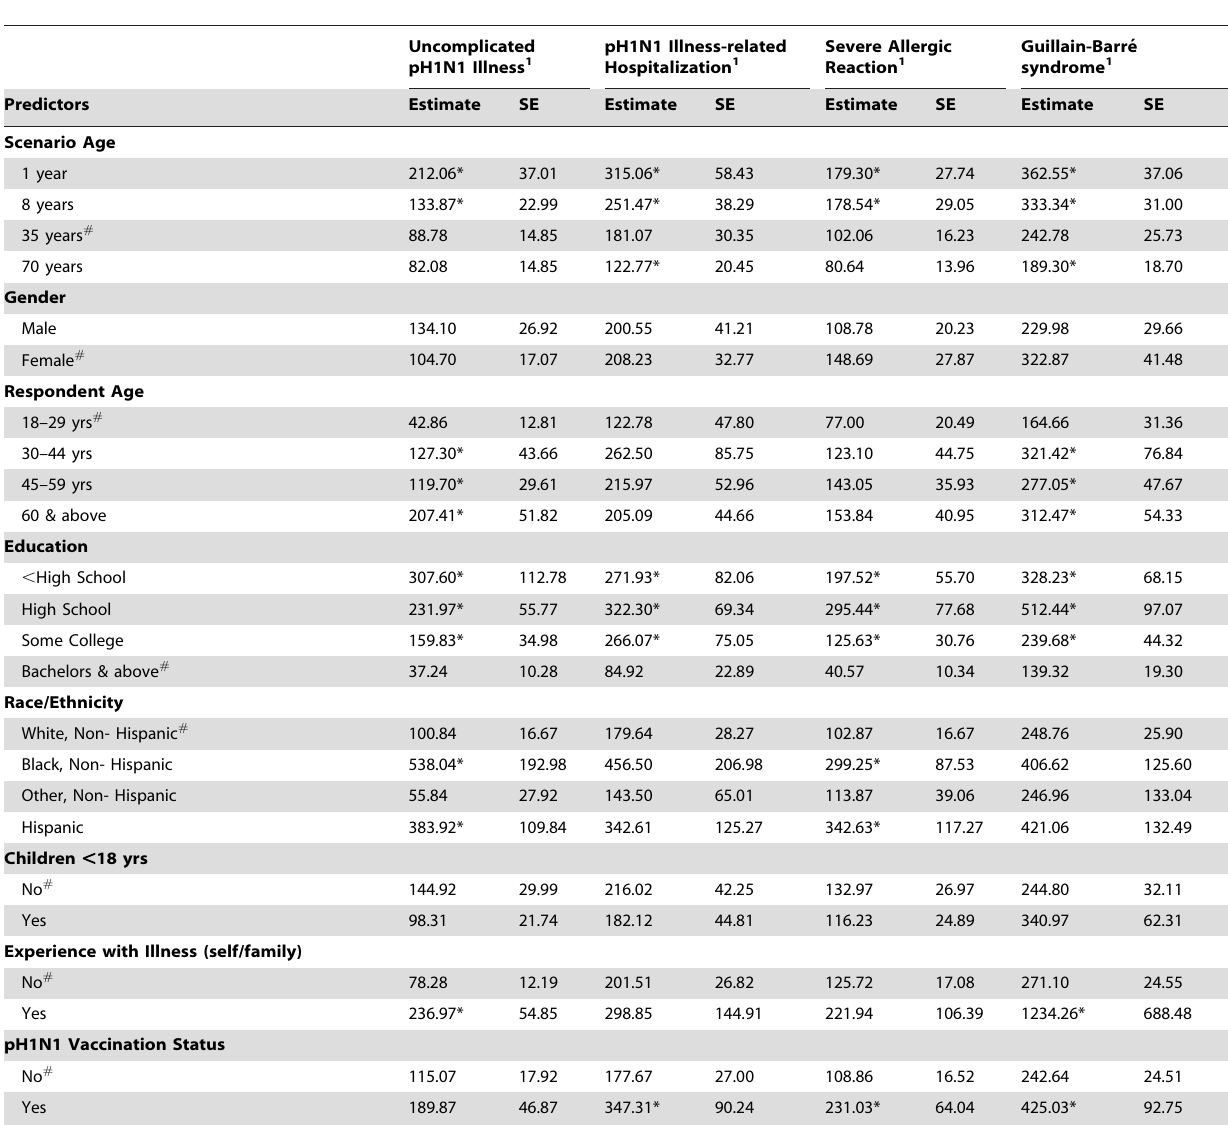
Table 5. Multivariate regression results: Time trade-off amounts by scenario age, sociodemographics, illness experience, and vaccination status, predicted number of days